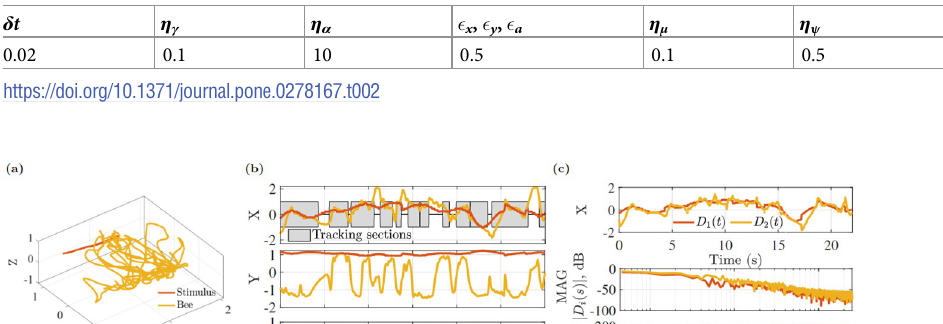
Table 2. Properties and thresholds taken for the data collection.